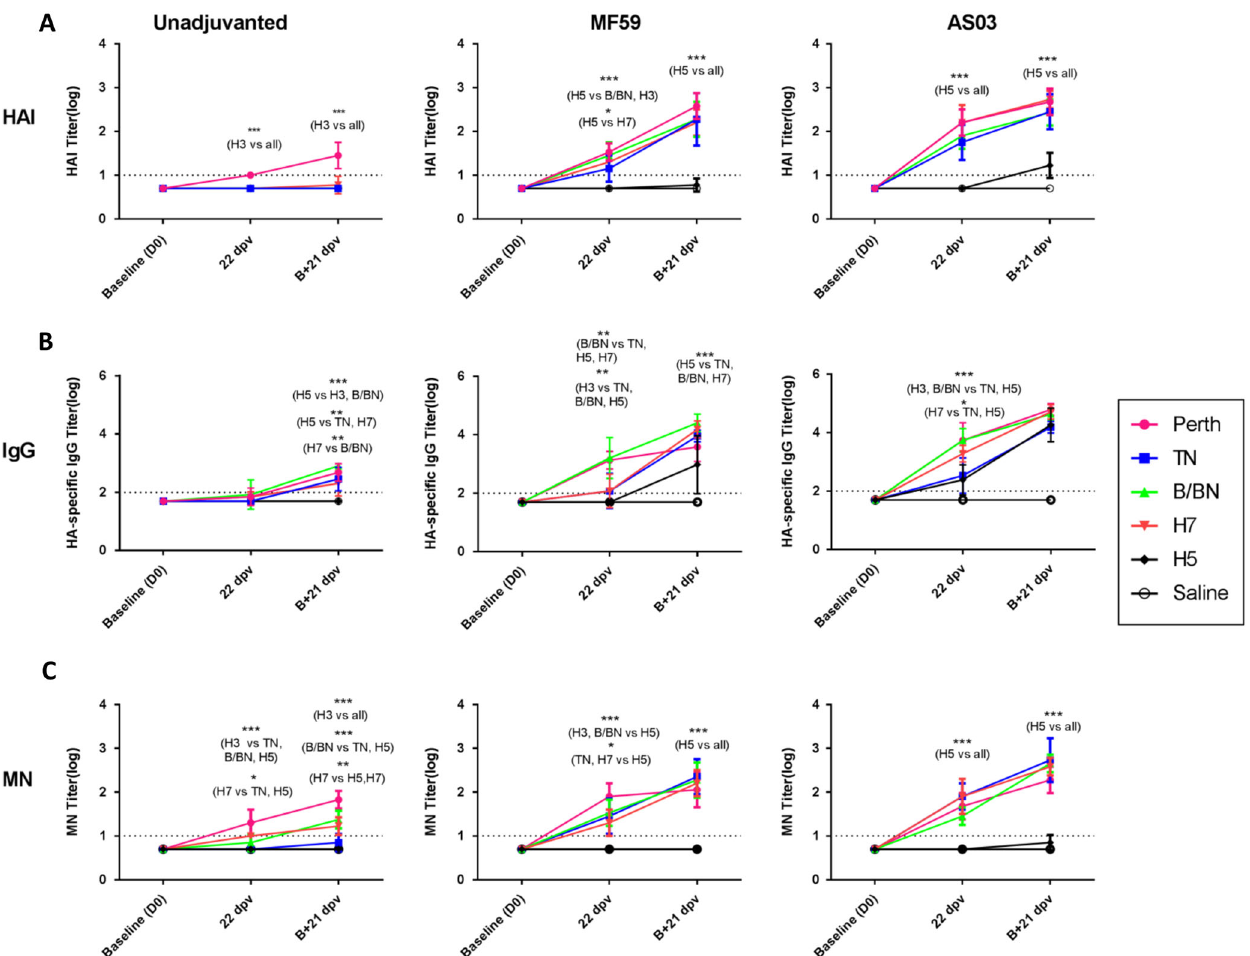
Fig. 2 Immunogenicity pro fi le in ferrets vaccinated with unadjuvanted, MF59 or AS03-adjuvanted TIV, H7N9 or H5N1 vaccines. Sera was collected after the fi rst dose given 22 days post-vaccination (DPV) and the second dose (B + 21 dpv) and tested by a hemagglutination- inhibition (HAI), b ELISA for antigen-speci fi c IgG and c microneutralization (MN) assay. Antibody titers are expressed as mean log 10 -antibody titer, with the error bars representing the standard deviation. Dashed line indicates the limit of assay detection; Y = 1 for HAI and MN assays and Y = 2 for ELISA. Statistically signi fi cant differences were tested by ANOVA of log-transformed antibody titers for all antigens and vaccine groups and post hoc tests with Bonferroni adjustments for multiple comparisons. Asterisk denotes p -value < 0.05, ** p < 0.01, *** p < 0.001. The complete results are provided in Supplemental Fig. 1